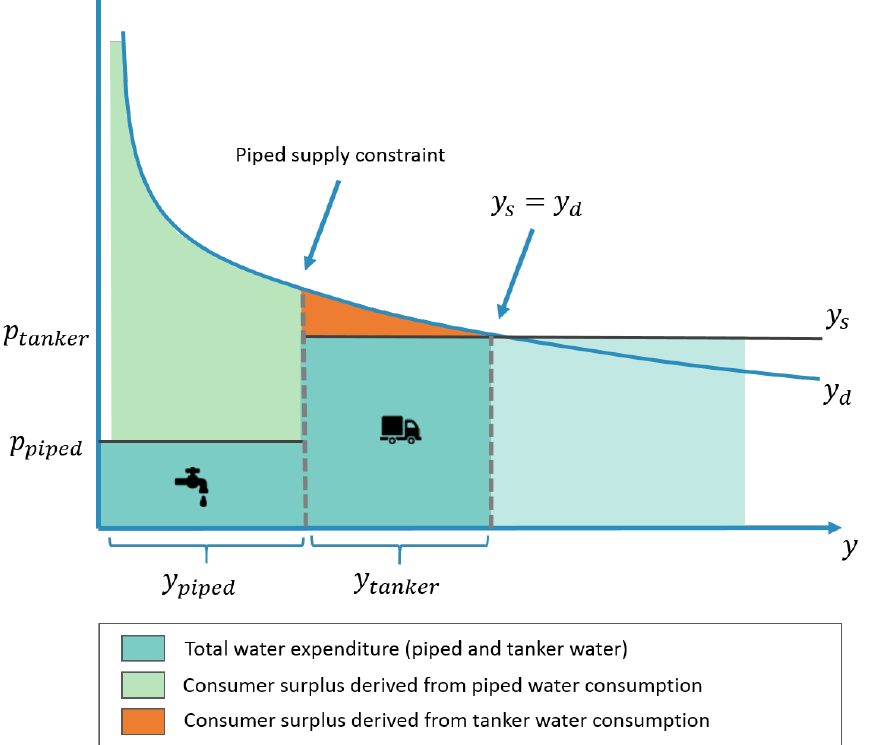
Figure 1. The tiered supply curve (based on [19,27]) runs along the upper boundaries of two blocks sorted in order of increasing prices per unit of water. The areas between those blocks and the demand curve of a commercial establishment are interpreted as the shares of consumer surplus, which can be attributed to water supplied from the respective source, indicated by the light green and orange areas (cf. Notes 8 & 9 in Appendix